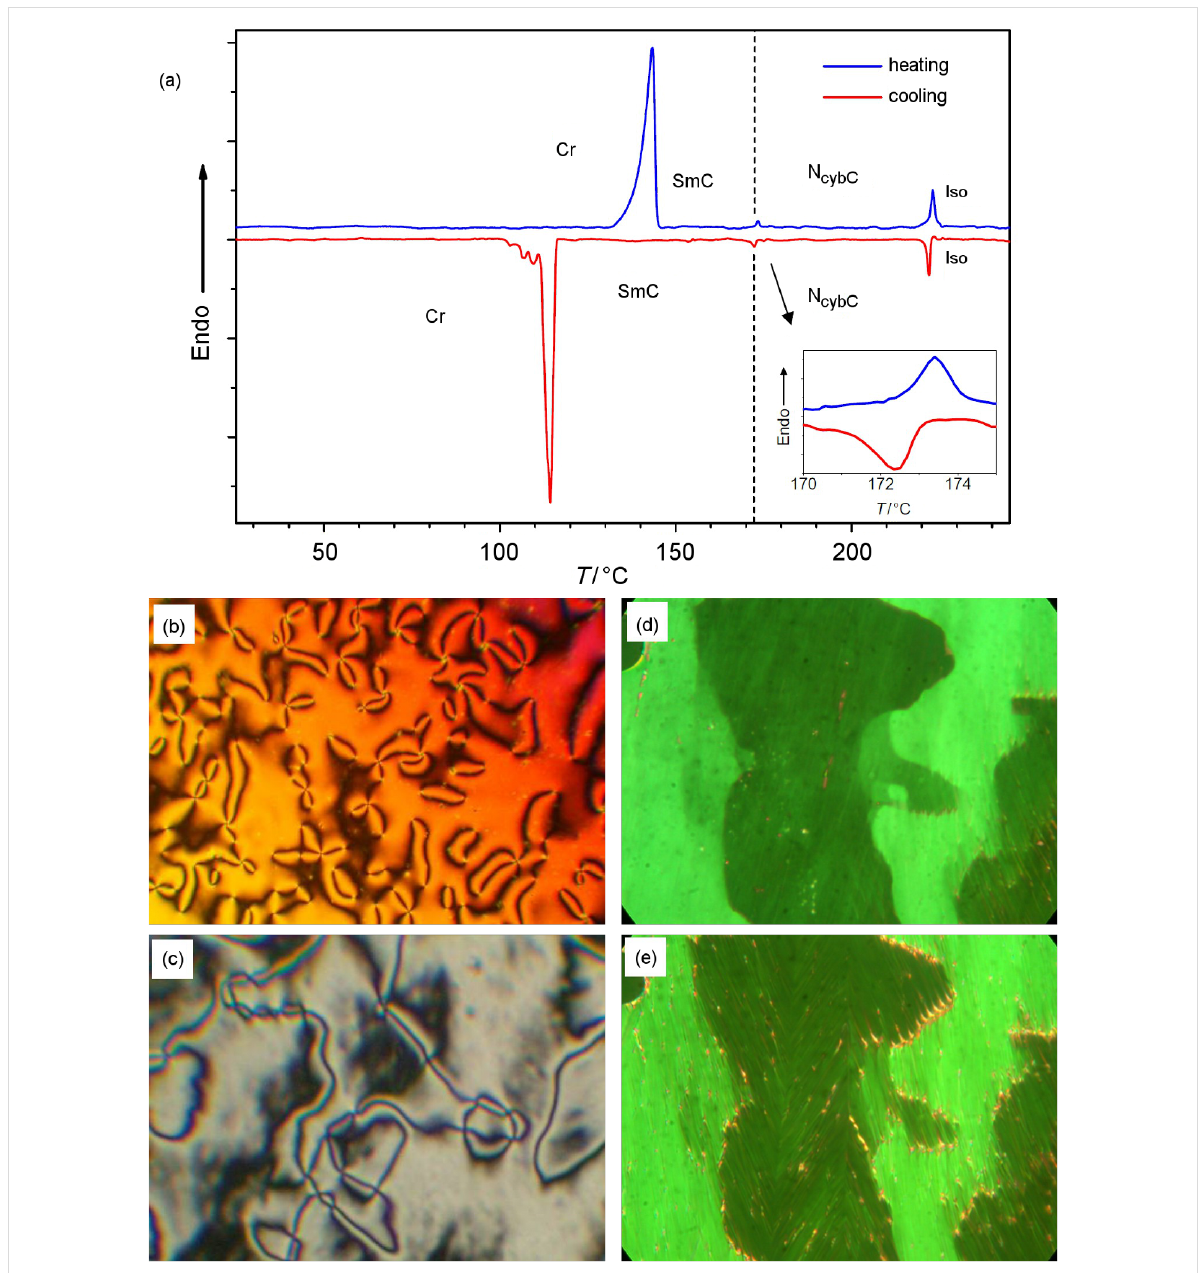
Figure 5: Dimesogen Thia-Ox/5 : (a) DSC traces obtained during first heating and cooling cycles scanned at a rate of 10 K min − 1 ; (b,c) textures as observed between crossed polarizers, (b) N phase having a Schlieren texture at T = 220 °C and (c) SmC phase at T = 160 °C under homeotropic boundary condition; (d) N phase and (e) SmC phase under homogeneous boundary conditions; the same temperatures as (b,c), observed in poly- imide-coated cells, 6 μ m.